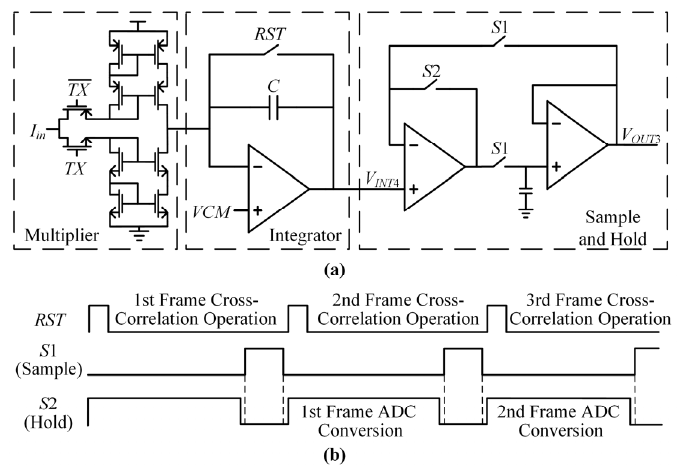
Figure 8. The scheme and working sequence of the proposed cross-correlation circuit, sample, and hold circuit. ( a ) The scheme; ( b ) the working